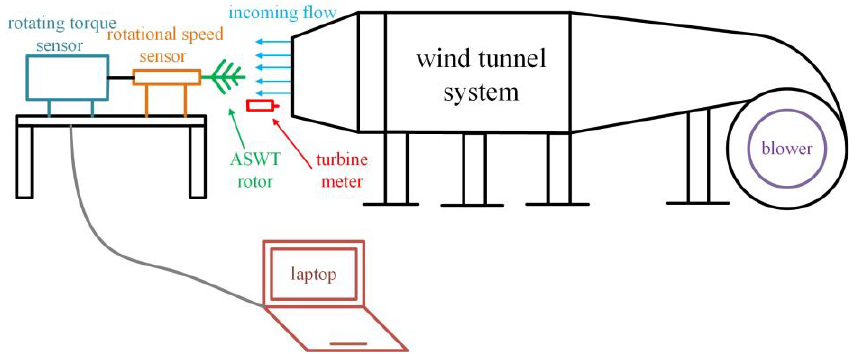
Figure 7. The wind tunnel test system.